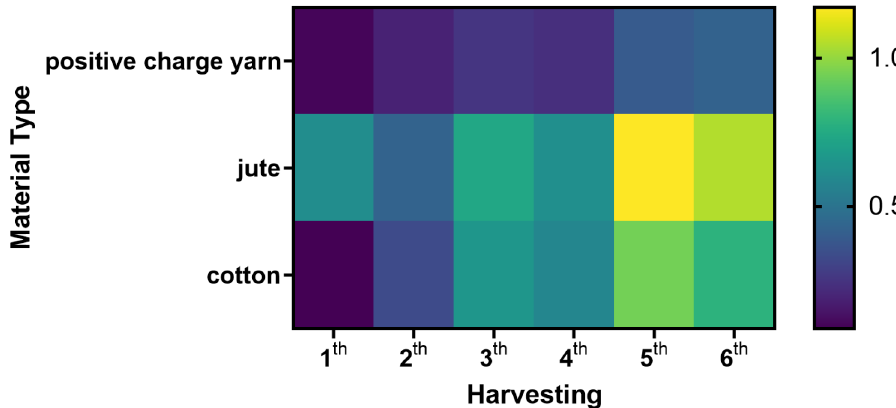
Fig. 4 Heat map of biomass productivity (g m -2 ) of Desmonostoc sp. strain in harvesting